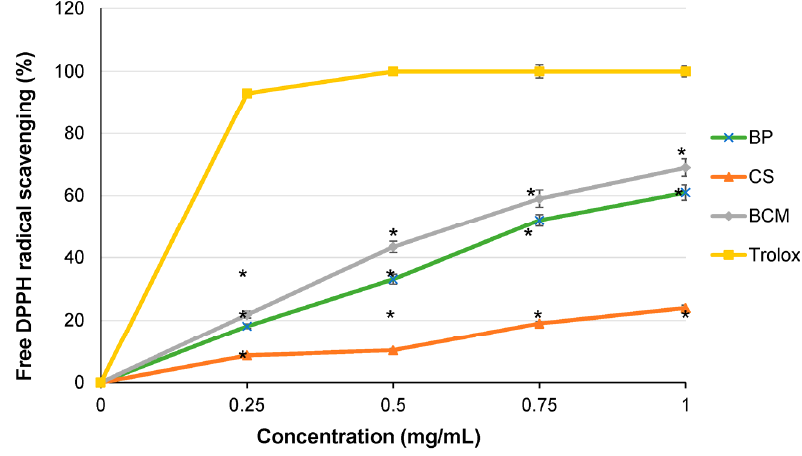
Figure 2. Free DPPH radical scavenging activity of blueberry pomace extract (BP), chia seed extract (CS) and their mixture (BCM). Trolox served as control. * p < 0.05, compared to control.